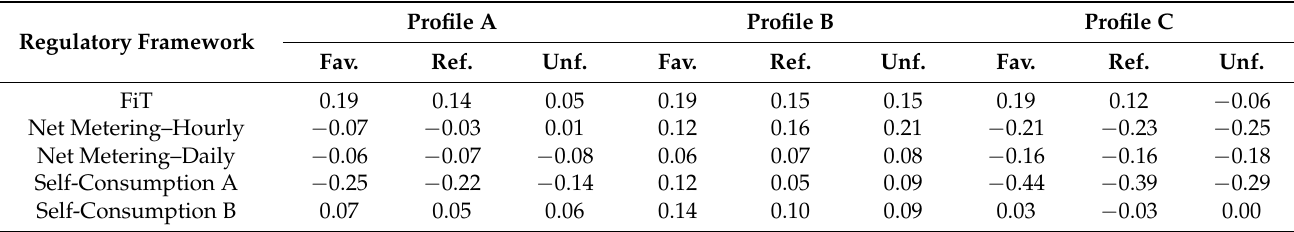
Table 5. Difference between the individual benefit and the mean benefit within a community, in € /day, for all profiles and regulatory frameworks considered in systems without ESS. Source: self-elaboration.